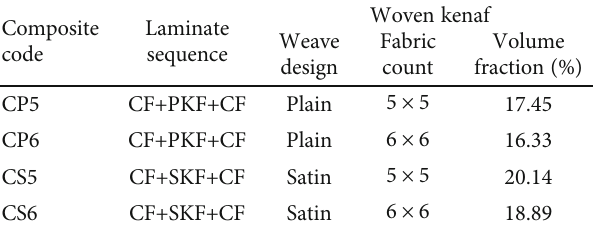
Table 2: Composition of kenaf woven in the hybrid